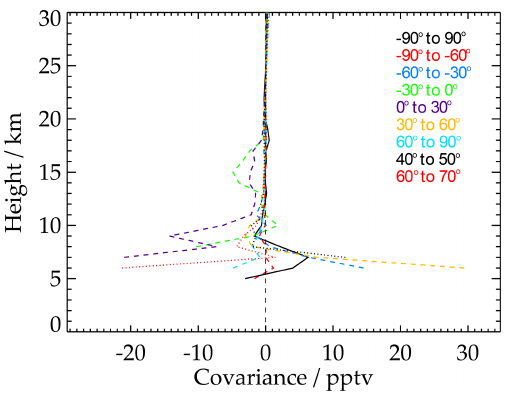
Figure 3. As in Fig 1 but for HCN.